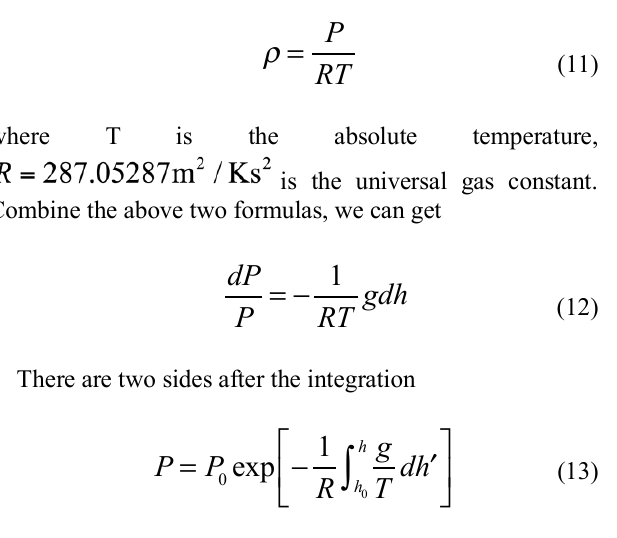
where P is the atmospheric pressure. g is the acceleration of gravity. ρ is the gas density. H is the geopotential height. S is is the cross-sectional area in the vertical direction.